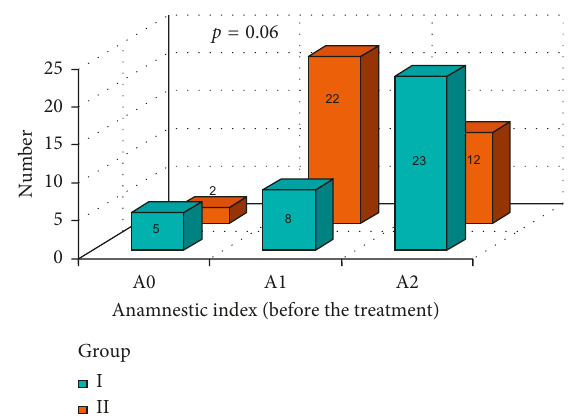
Figure 5: Anamnestic index (AI) in both groups before the prosthodontic